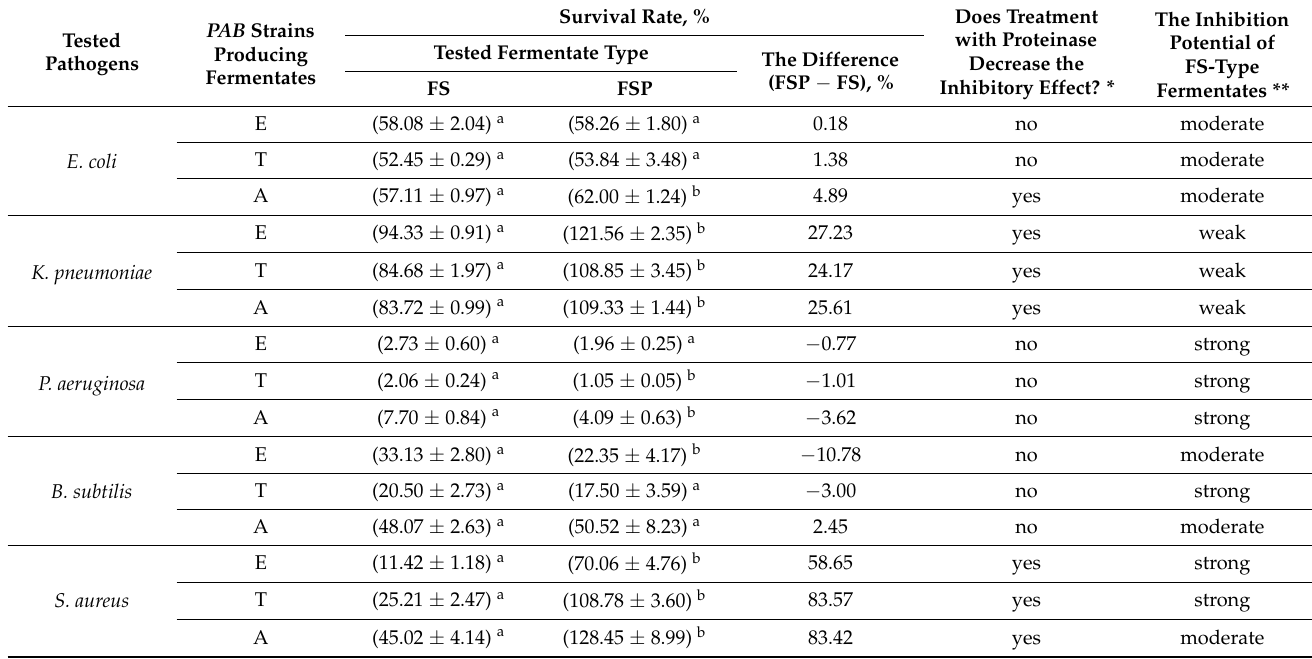
Table 4. Antimicrobial effects of PAB fermentates against B. subtilis , E. coli , K. pneumoniae , P. aeruginosa and S. aureus after 10 h